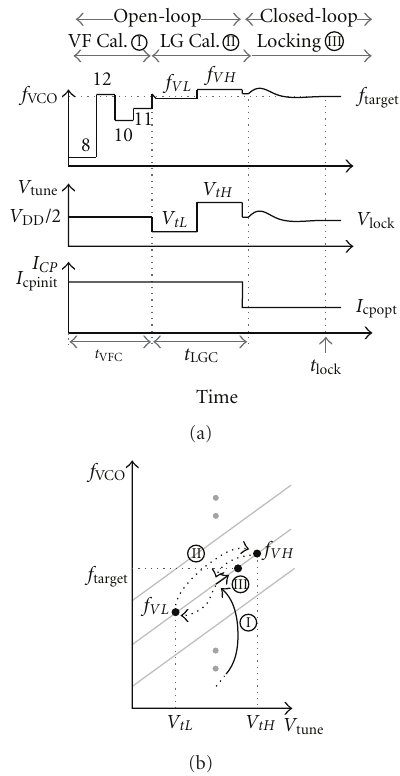
Figure 12: (a) Transitions of f VCO , V tune , and I CP during calibration and locking process. (b) Transition of f VCO during calibration.